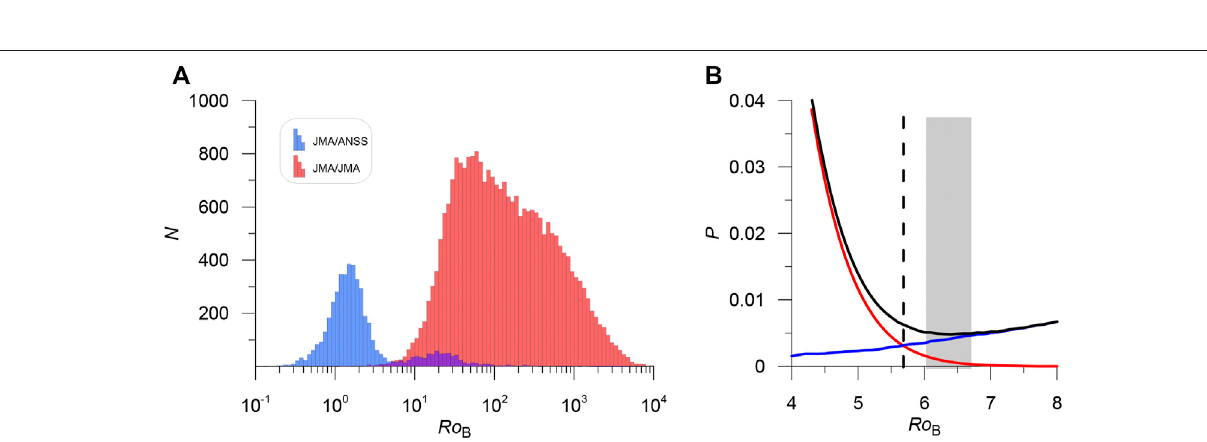
Frontiers in Earth Science |